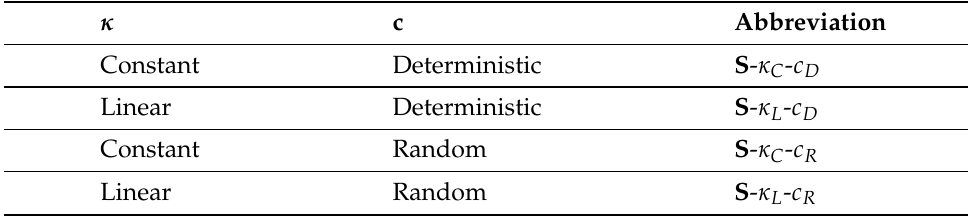
Figure 4. Graphical representation for the linear spatial distribution of the compressibility factor. Horizontal axis stands for the compressibility factor κ and the vertical axis for the depth of the soil point in meters. The spatial distributions for the mean value µ of the ratio R = κ z = max corresponding distributions for µ + σ and µ − σ . Table 3. Non-porous (solid) analyses performed.